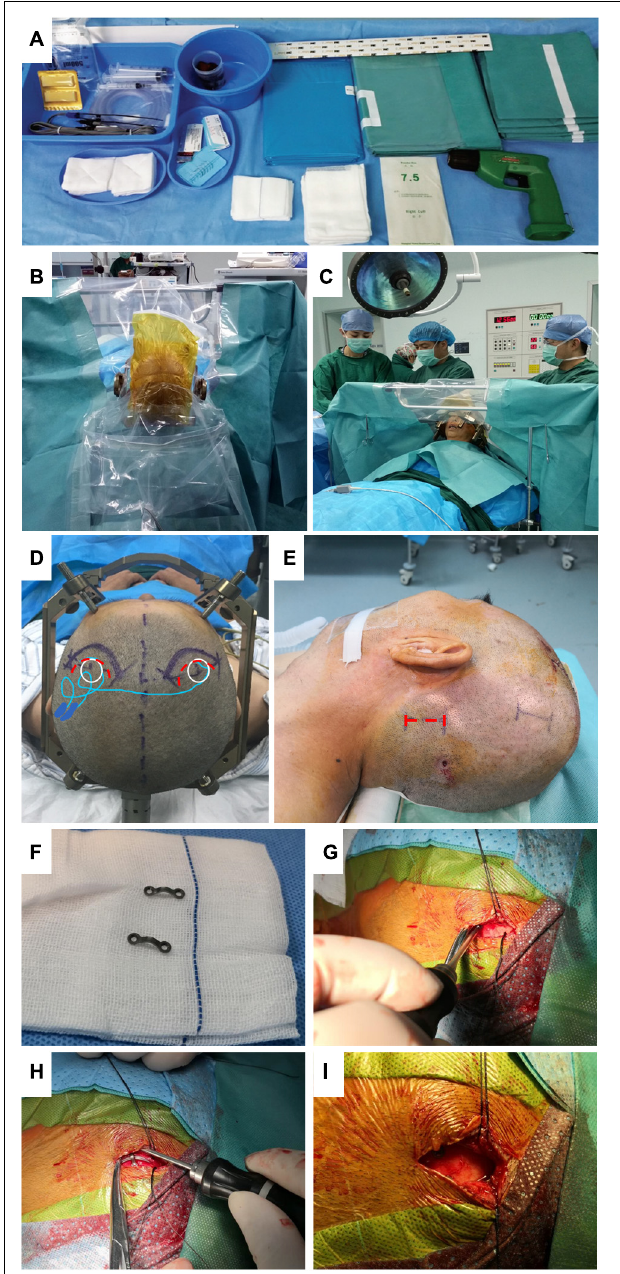
FIGURE 1 | DBS Surgical modificationsin our center. (A) Demonstration of the non-woven drape exclusive for DBS surgery. (B,C) Transparent polyethylene film was easy to use and facilitated patient-surgeon communication during surgery. (D) Compared to the original incision on the coronal suture (red dotted curve), the distance between our modified forward-moving incision (purple solid curves) and burr hole and incision was increased to avoid placing hardware directly under the suture line. (E) The incision for the extension wire was moved upwards from occipital/mastoid region (red dotted line) to parietal eminence region (purple solid line) with thick skin and no lymph nodes. (F) Titanium microplate was bent to constrain the connector. (G,H) The skin was retracted aside so that the microplate was easily fixed to the skull. (I) Direct extension wire implantation under the suture line should be meticulously